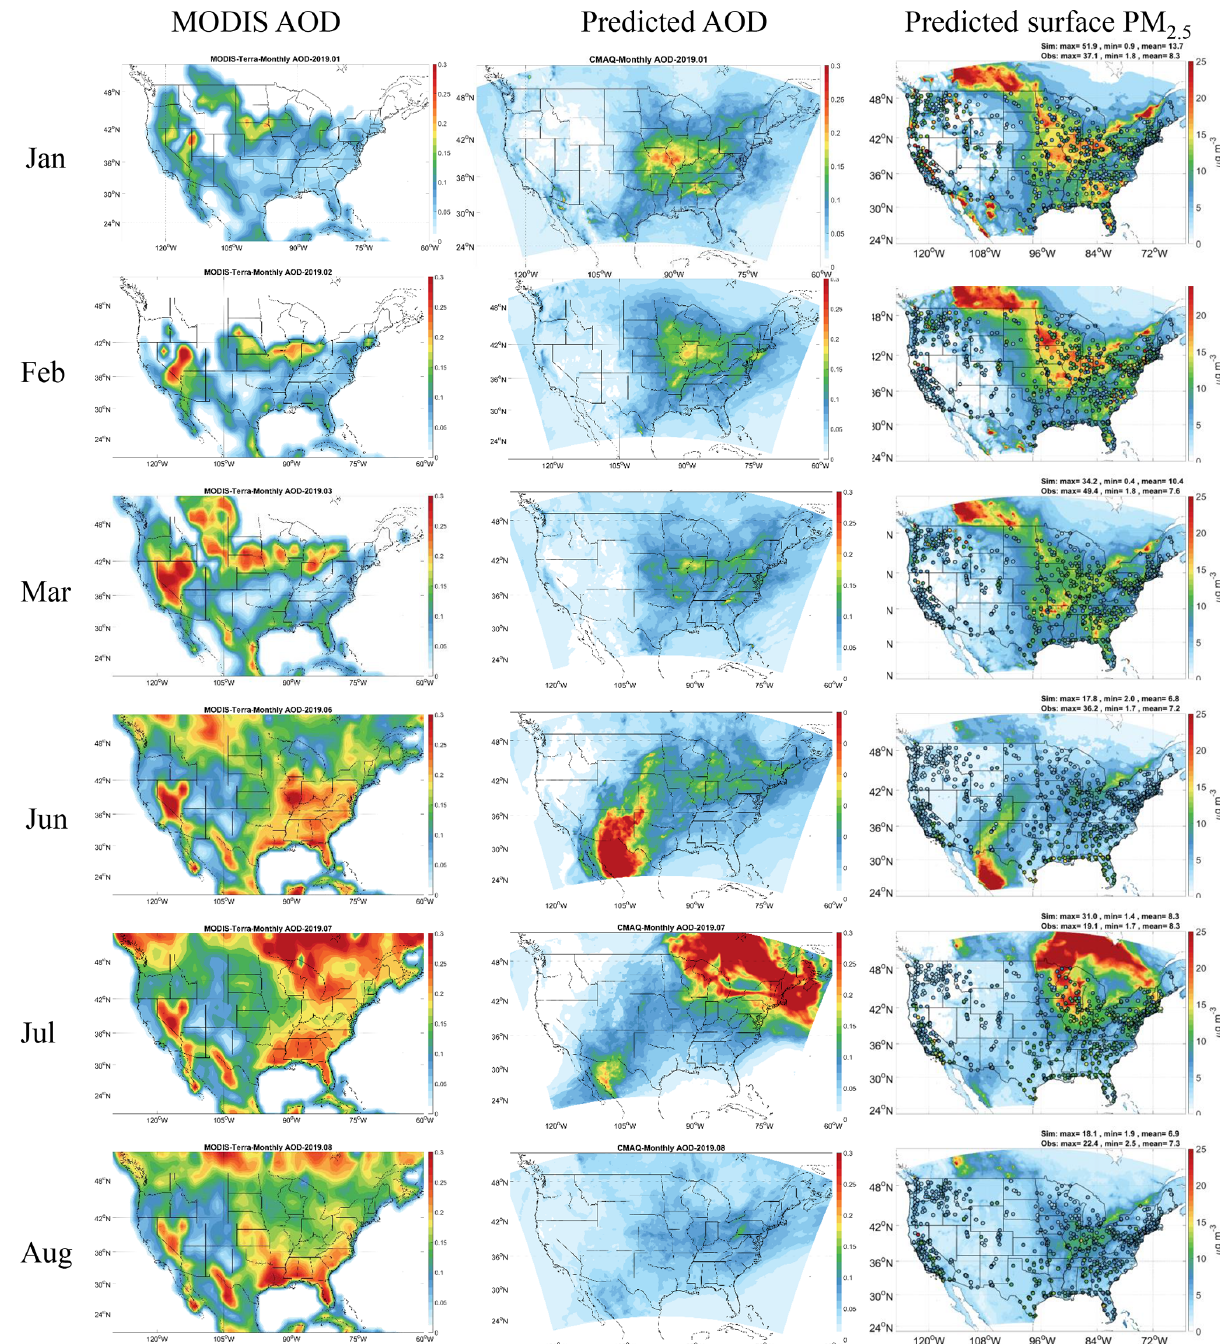
Figure 4. Monthly AOD from MODIS (left), predicted AOD from GFSv15–CMAQv5.0.2 (middle), and predicted surface 24h average PM 2 . 5